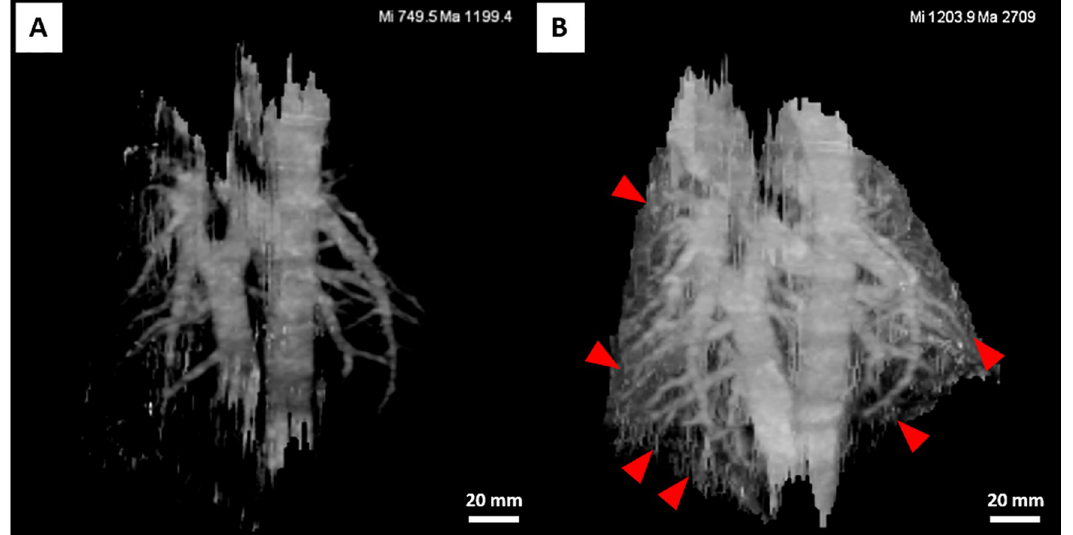
Fig 2. Representative 3D reconstruction of rabbit pulmonary vasculature shows increased vascular branch visualization following CF800 injection. (A) Pulmonary vasculature in the CT image acquired before CF800 injection. (B) Pulmonary vasculature in the CT image acquired 5 minutes after CF800 injection. Images are depicted using a thresholding-based method with lower and upper threshold values set at 25–40% of maximum intensity within the segmented lungs (values on top-right). Small pulmonary vasculature branches at the distal branch generations can be segmented in the post-injection image due to increased attenuation